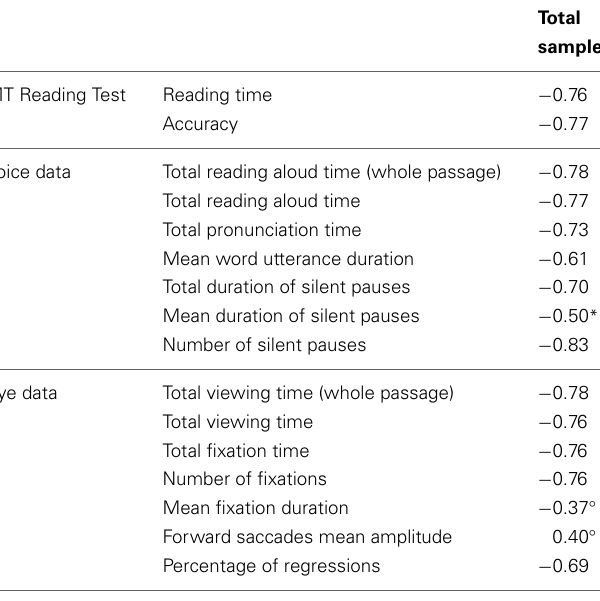
Table 6 | Pearson correlations between the eye-voice lead (based on averaged eye-voice position differences) and various parameters of functional reading (MT Reading test), reading aloud, and eye movement